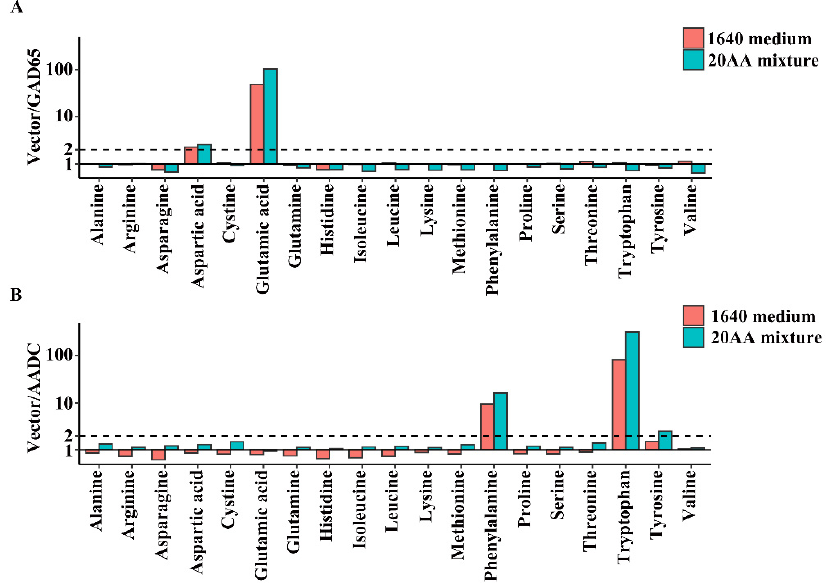
Figure 4. Detection and analysis of enzymatic activity reactions of GAD65, AADC with 20 amino acid mixture or 1640 medium. ( A ) The purified Vector and GAD65 were subjected to enzymatic reaction with 20 amino acids or 1640 medium, respectively. After incubation at room temperature for 2 h, the samples after enzymatic reaction were extracted and analyzed by LC-MS. ( B ) The purified Vector and AADC were subjected to enzymatic reaction with 20 amino acids or 1640 medium, respectively. After incubation at room temperature for 2 h, the samples after enzymatic reaction were extracted and analyzed by LC-MS.